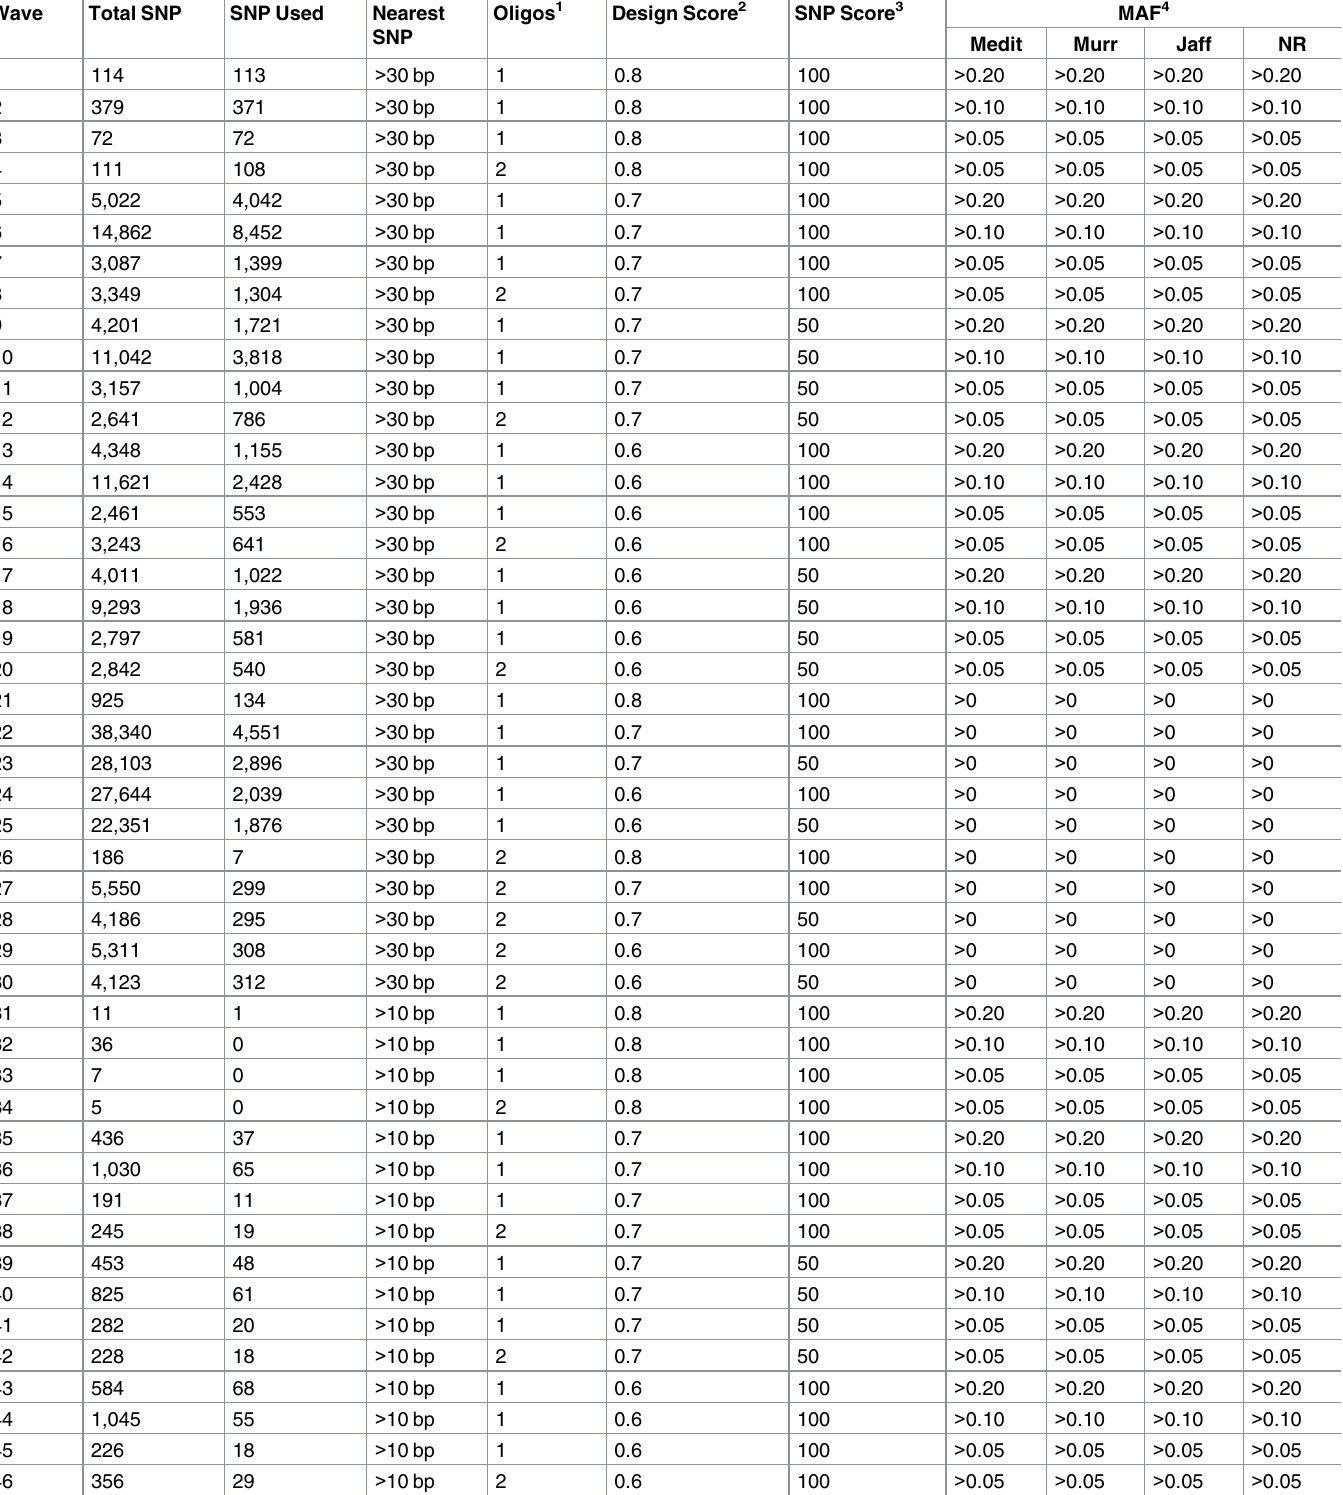
Table 3. Criteria of SNP used in each wave of SNP selection, total number that met the criteria, and number used from that